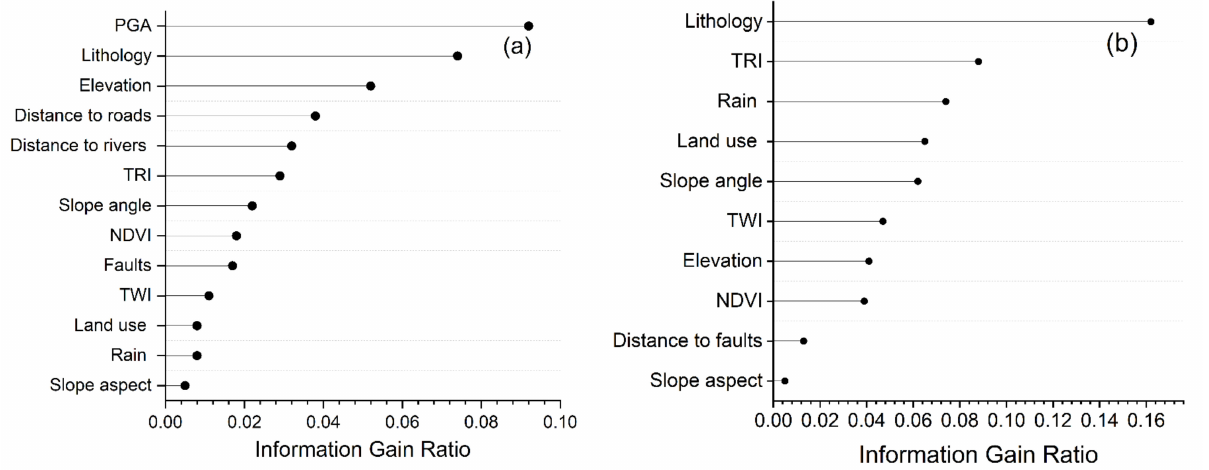
Figure 6. The results of factors analysis of the IGR method for ( a ) Zhangzha Town and ( b ) Lantau Island. Different from the IGR results of Zhangzha Town, the top three factors of Lantau Island are lithology, TRI, and yearly precipitation. The yearly precipitation becomes a governing factor among all factors, while the weight of elevation and related topographic factors are slightly reduced. As described in Section 2.1, Lantau Island suffers from a high annual precipitation, frequent high-intensity storms, and typhoons, thus resulting in the high weight of